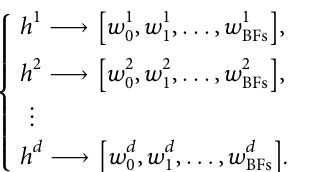
Figure 5: Curves of DMPs modulated according to different target